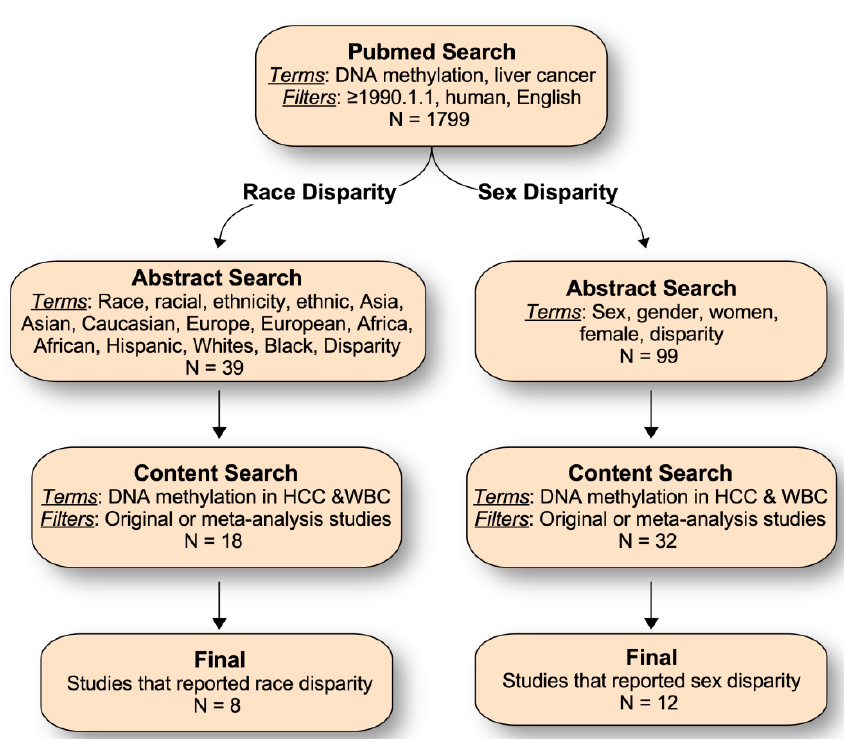
Figure 3. Schematic of literature search strategies used in this study.